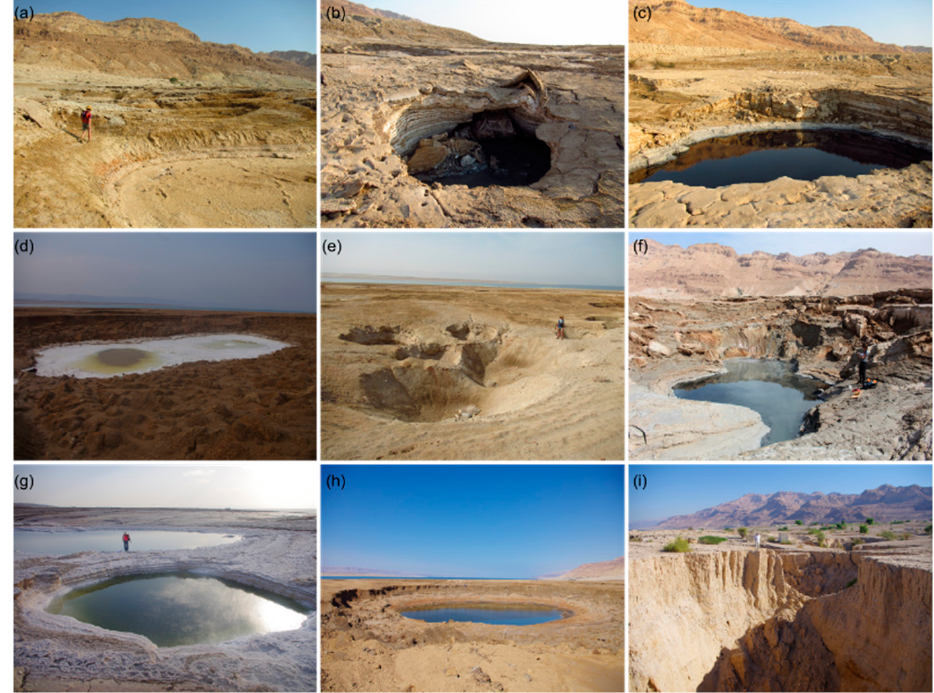
Figure 8. Highlight area—sinkhole and subsidence around Ghor Al-Haditha. Different collapse types in a variety of materials: ( a ) wide and shallow sinkhole in mud, ( b ) steep sinkhole in salt and mud cover, ( c ) spring inside a sinkhole in salty mud, ( d ) connected wide sinkholes in mud with a filling of salt, ( e ) a group of sinkholes in sand cover, ( f ) cracked and moved ground at a spring-based sinkhole in salt and mud cover, ( g ) water-filled sinkhole in pure salt, ( h ) water-filled sinkhole in mud, and ( i ) deep and narrow sinkhole aggregation in alluvium. All photos were taken by Djamil Al-Halbouni. Stream channels, springs, and